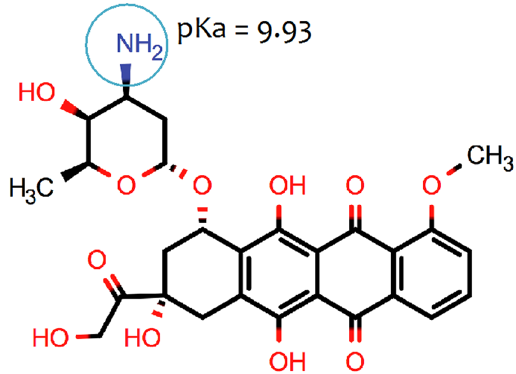
Figure 1. Molecular structure and pKa value of